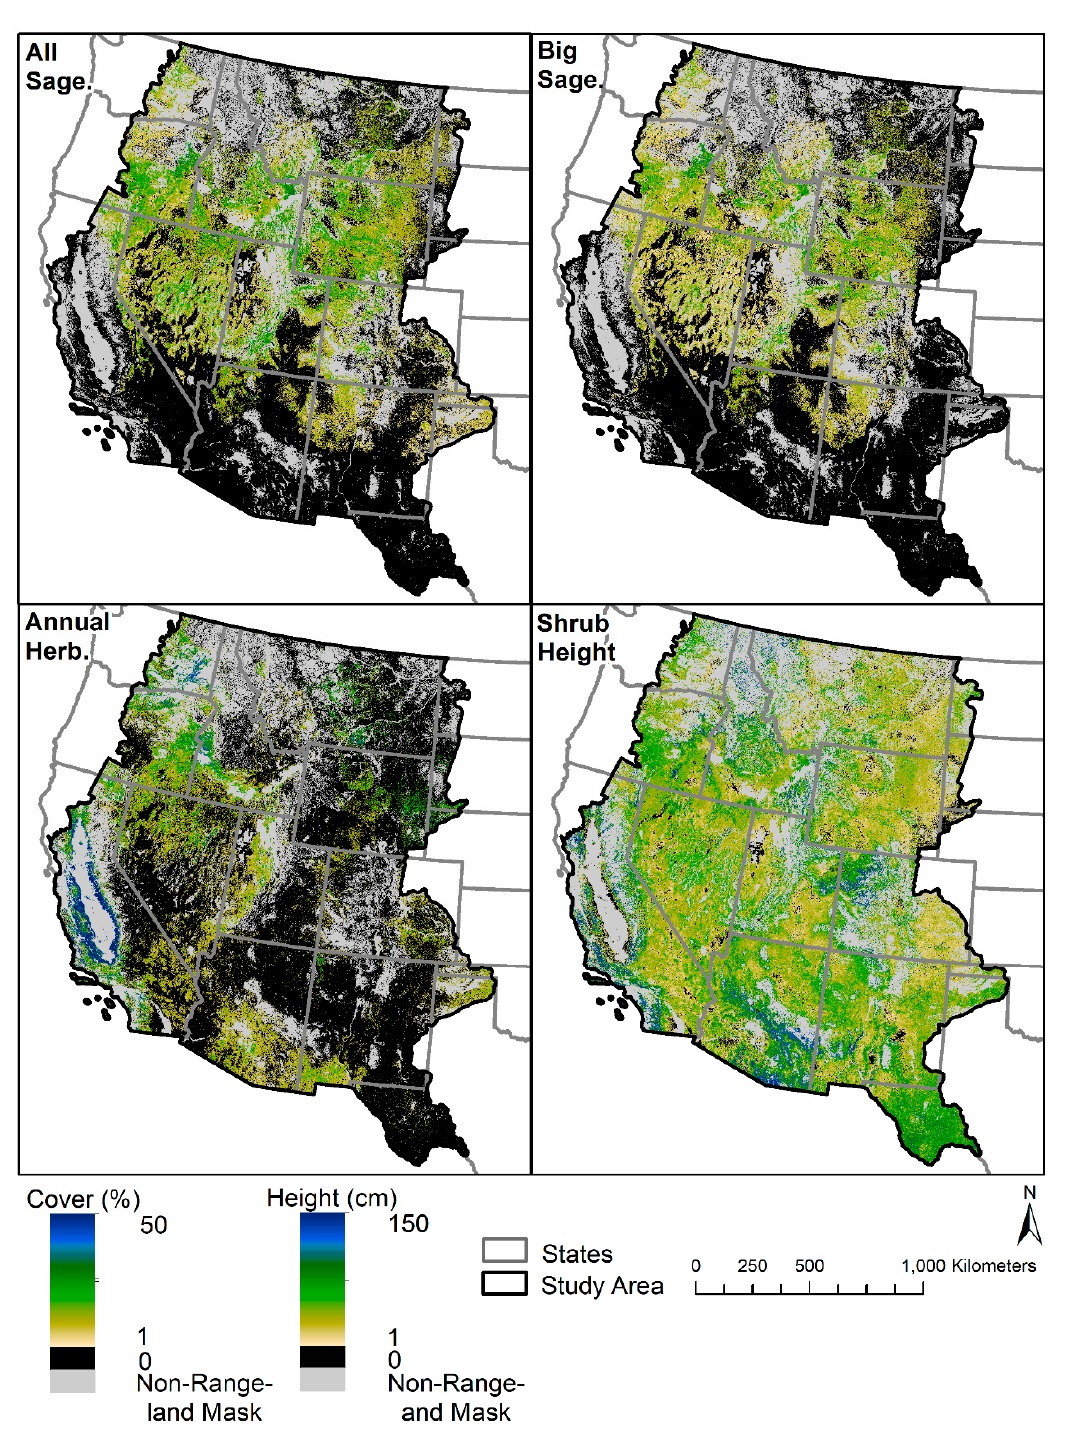
Figure 4. Distribution of secondary fractional cover components; all sagebrush, big sagebrush, and annual herbaceous, and shrub height in cm. Note the color ramps of all sagebrush, big sagebrush, and annual herbaceous have been truncated to a range of 0–50% cover and shrub height truncated to 0–150 cm to enhance visualization.